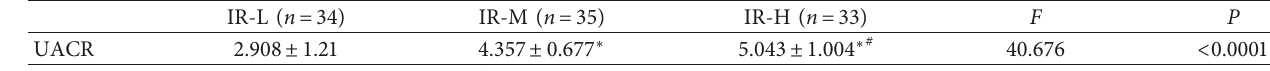
Table 3: Comparison of UACR in three HOMA-IR groups.